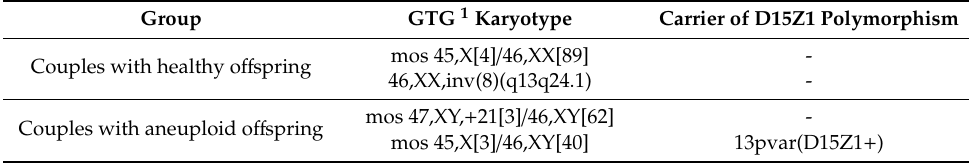
Table 1. Abnormal karyotypes in four individuals from the two groups of couples. Group GTG 1 Karyotype Carrier of D15Z1 Polymorphism mos 45,X[4] / 46,XX[89] - Couples with healthy o ff spring 46,XX,inv(8)(q13q24.1) Couples with aneuploid o ff spring